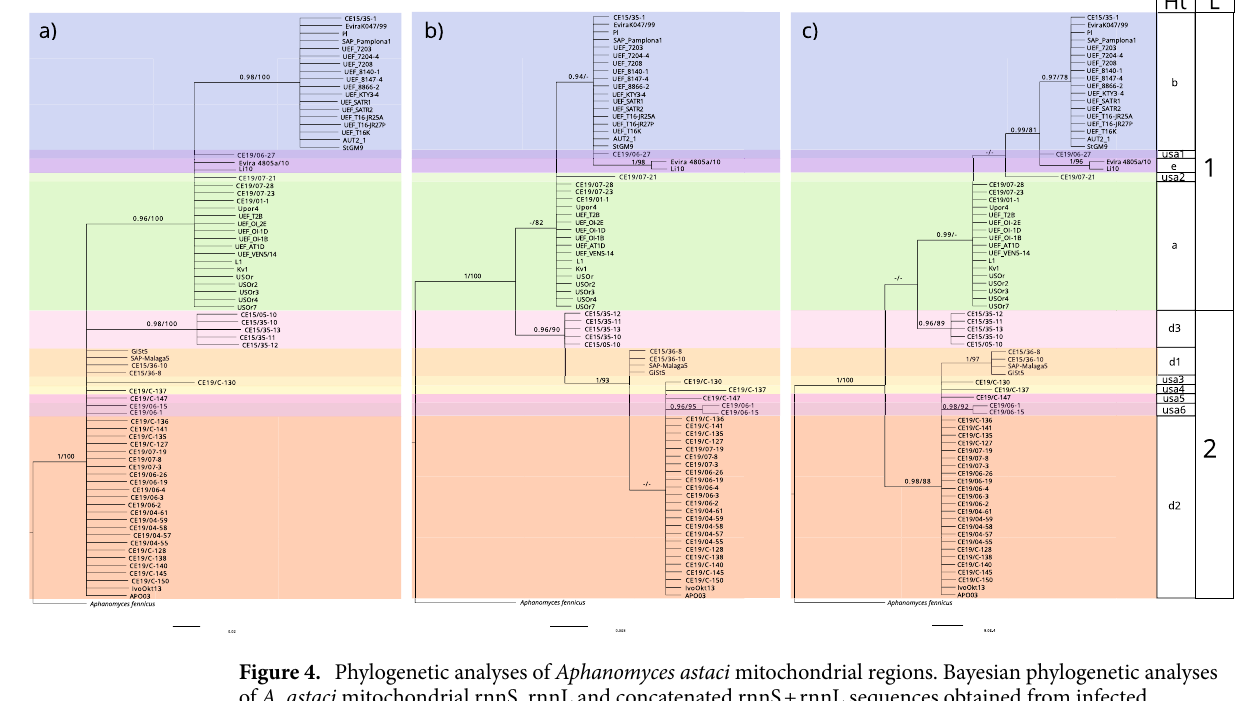
Figure 4. Phylogenetic analyses of Aphanomyces astaci mitochondrial regions. Bayesian phylogenetic analyses of A. astaci mitochondrial rnnS, rnnL and concatenated rnnS + rnnL sequences obtained from infected crayfish specimens and previous studies 33,52,53,62 . ( a ) Bayesian phylogenetic tree based on the rnnS sequences, ( b ) Bayesian phylogenetic tree based on the rnnL sequences, ( c ) Bayesian phylogenetic tree based on the concatenated rnnS + rnnL sequences. Values above the branches represent the Bayesian posterior probabilities (> 0.95) and ML bootstrap support values (> 75), respectively. Scale bar for phylogenetic analysis indicates substitutions per site. Abbreviations: Ht, haplotypes; L, lineages.